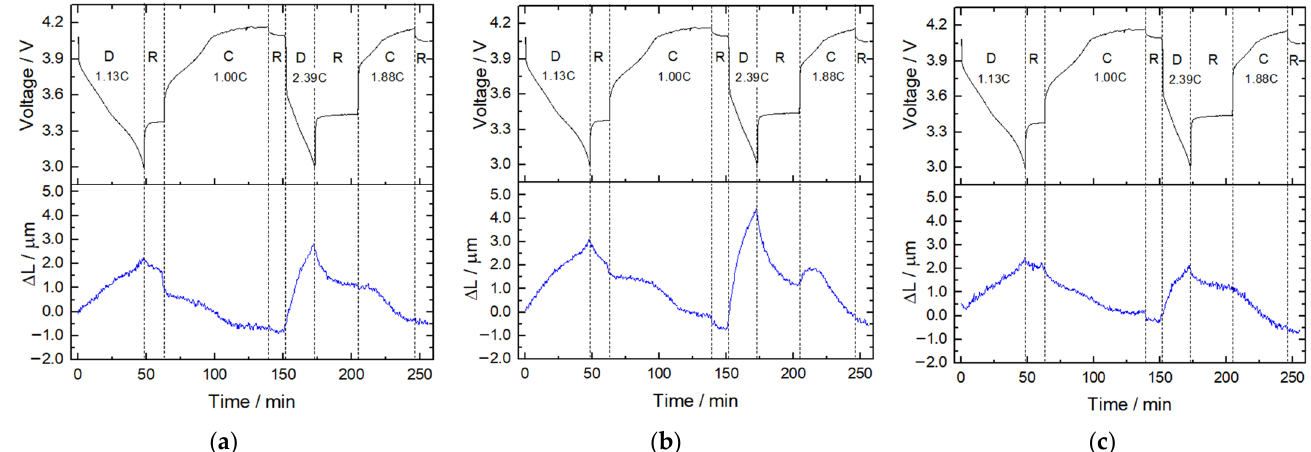
Figure 7. Deformation variation detected by the PM ‐ FBG sensors over voltage signal for ( a ) negative terminal, ( b ) middle, and ( c ) positive terminal of the battery. Higher deformation variation was recorded in the middle location, at the end of abusive discharge, where a 0.02% variation occurred. The higher deformation registered in the charge steps were in the early beginning of such processes, presenting a lower relative displacement of 0.01%, also in the middle location. The battery terminals tended to present lower deformation values.